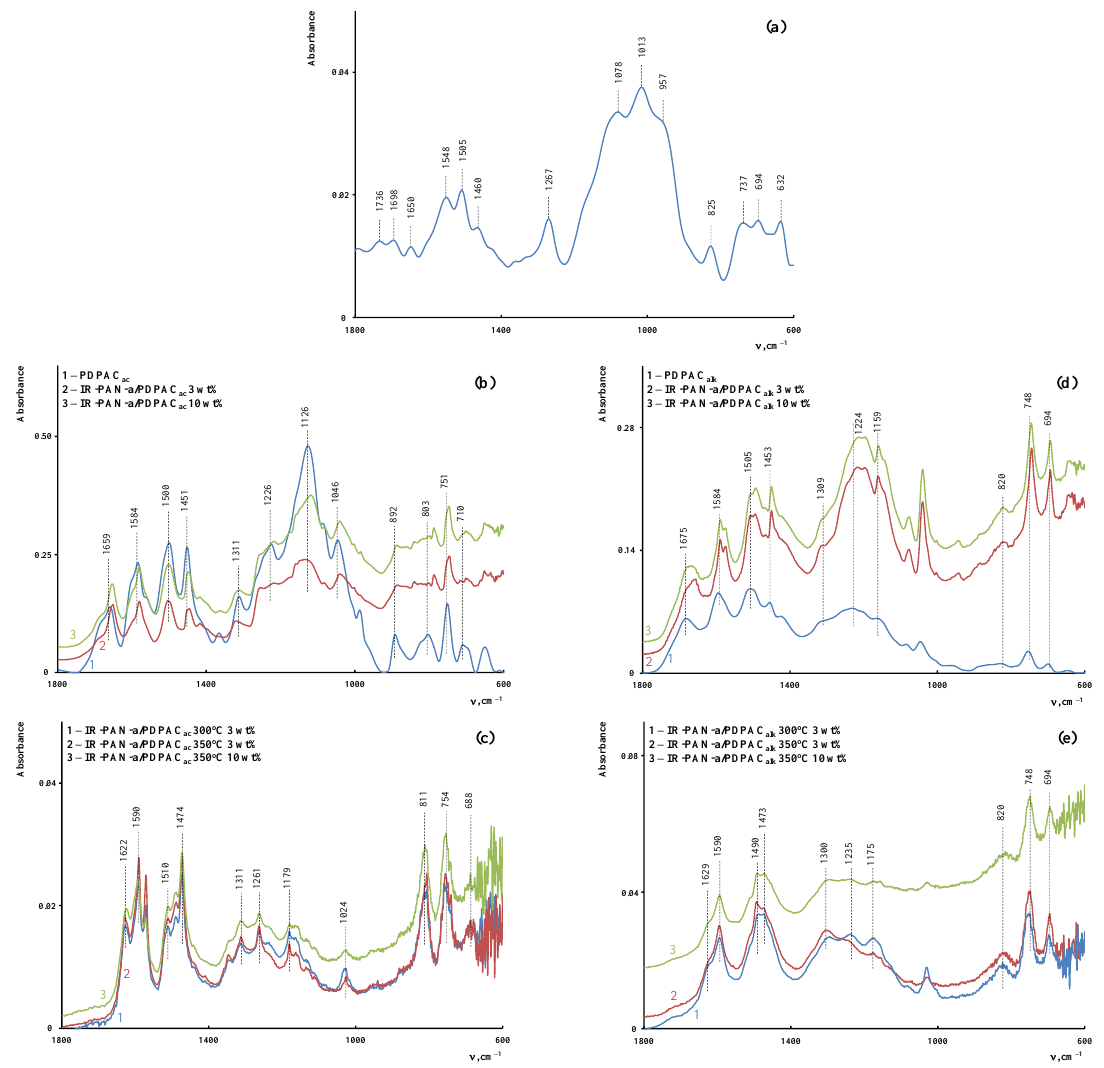
Figure 4. Attenuated total reflection (ATR) FTIR spectra of IR-PAN-a ( a ), PDPAC and IR-PAN-a/PDPAC ( b , d ), and IR-PAN-a/PDPAC IR ( c , e ), prepared in an acidic ( b , c ) and an alkaline medium ( d , e ). As can be seen, the chemical structure of the polymer component has a strong dependency on the pH of the reaction medium for the composite synthesis. During the polymerization of DPAC in an acidic medium (pH 0.3) in the presence of IR-PAN-a, the polymer chain grows via the C–C bonding into the para position of the phenyl rings relative to nitrogen. In the IR-PAN-a/PDPAC ac composite, the absorption bands at 751, 785, and 892 cm − 1 are due to the out-of-plane bending vibrations of the δ C– Н bonds of the 1,2-, 1,2,4-, and 1,4-substituted benzene rings, respectively. During the polymerization of DPAC in the heterophase system in an alkaline medium (pH 11.4) in the presence of IR-PAN-a, the polymer chain grows via the C–C bonding into the 2- and 4-positions of the phenyl rings relative to nitrogen. In the IR-PAN-a/PDPAC alk composite, the absorption bands at 745 and 820 cm − 1 correspond to out-of-plane bending vibrations of the δ C– Н bonds of the 1,2-disubstituted and 1,2,4-trisubstituted benzene rings. The shift in the absorption